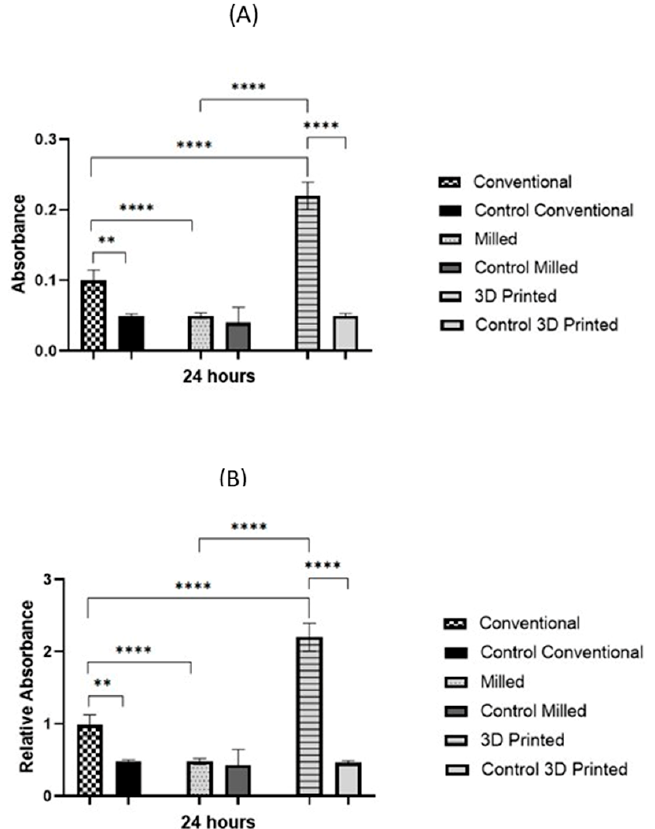
Figure 6. Biofilm assessment on conventional, milled, and 3D-printed groups and the control of each denture type. Average absorbance obtained with the XTT assay for C. albicans adhered for 24 h ( A ), and relative absorbance obtained with the XTT assay for C. albicans adhered for 24 h ( B ). Significance level is indicated by asterisks (** p = 0.005; ****, p < 0.001). The data display the mean of either absorbance or relative absorbance of each denture group to its control denture